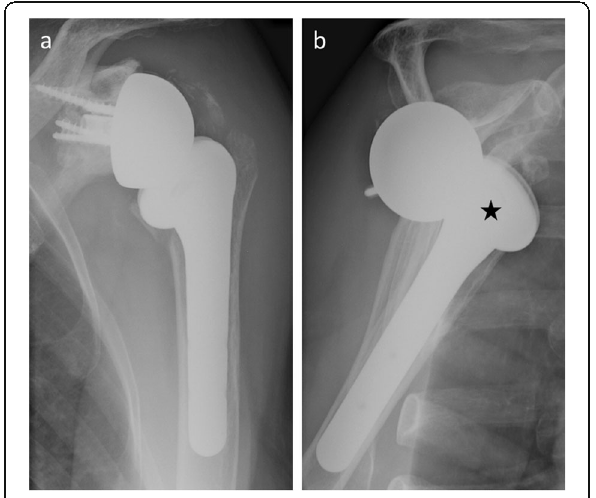
Fig. 12 Anteroposterior ( a ) and scapular Y ( b ) radiographs of a 76-year- old woman with reverse shoulder arthroplasty (2months after surgery) show an evident anterior dislocation (star) in scapular Y view. Note that this dislocation is difficult to highlight on anteroposterior